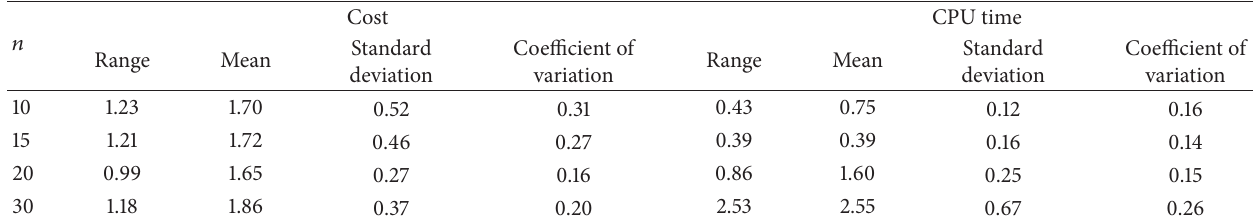
Table 3: The results with different 𝑛 (cost: million yuan, CPU time: second).